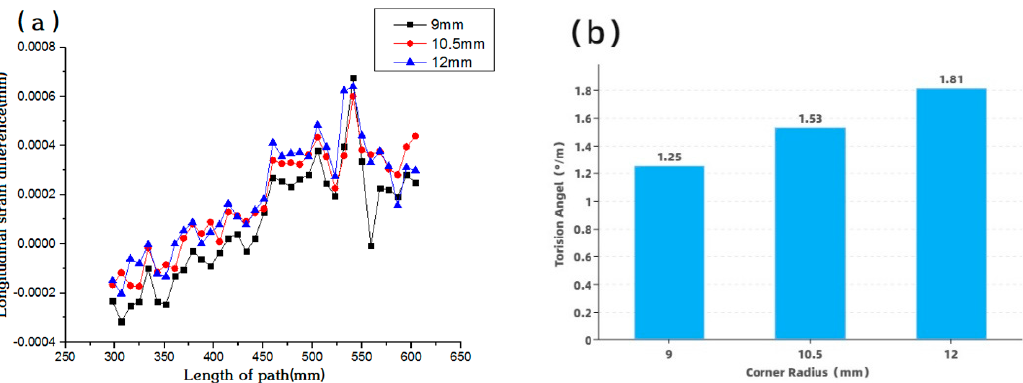
Figure 12. Simulation results of different corner radii. ( a ) Influence of different corner radius on torsion; ( b ) Torsion decrease about 0.28°/m with an average 1.5 mm decrease in corner radius.